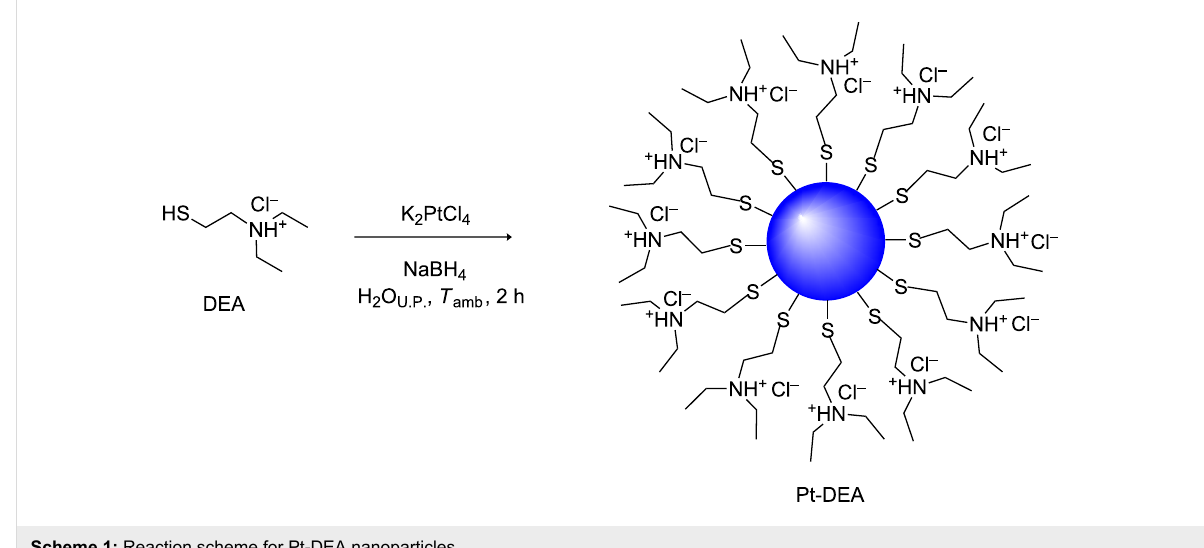
Scheme 1: Reaction scheme for Pt-DEA